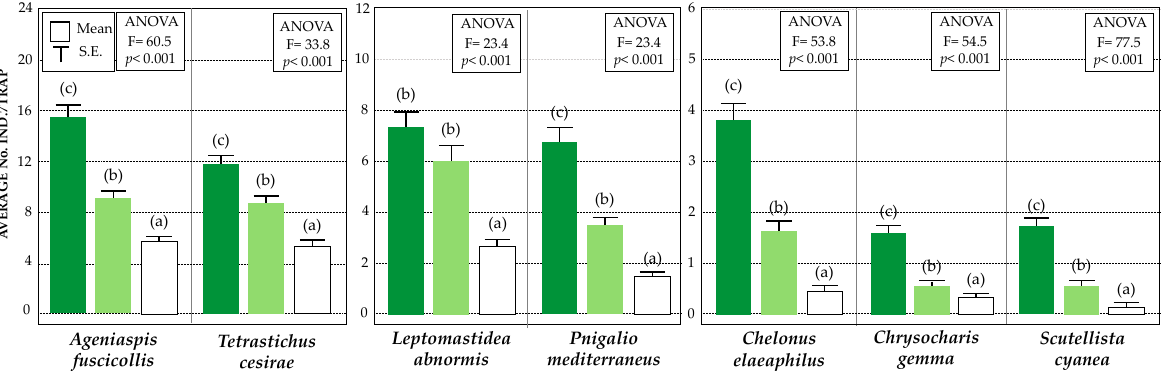
Figure 4. Statistics (mean and SE) of the relative abundances of main parasitoid species captured in the sticky yellow traps in the three farming managements: Conventional (white), VC olive grove (light green), and VC-MIX olive grove (dark green). Statistically significant differences are indicated by letters (Tukey’s HSD test, p < 0.05).